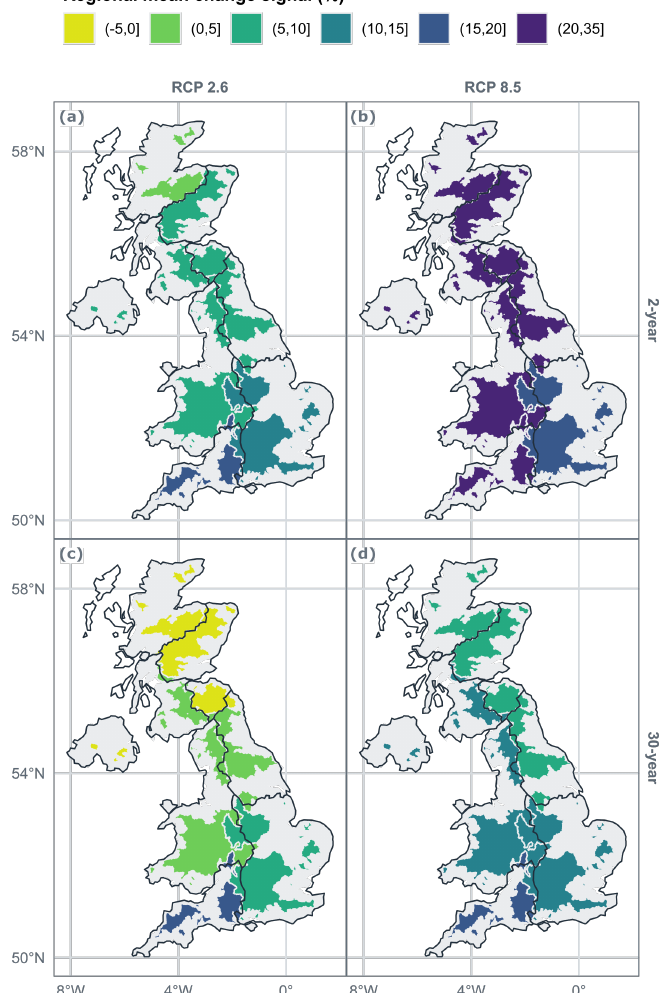
Figure 4. Regional mean change signal across the UK using the generalised extreme value (GEV) distribution for the ( a ) 1:2-year return period (RP) under Representative Concentration Pathway (RCP) 2.6; ( b ) 1:2-year RP under RCP 8.5; ( c ) 1:30-year RP under RCP 2.6; and ( d ) 1:30-year RP under RCP 8.5. The generalised logistic (GL) distribution is not shown, as the results are almost identical (see Supplementary